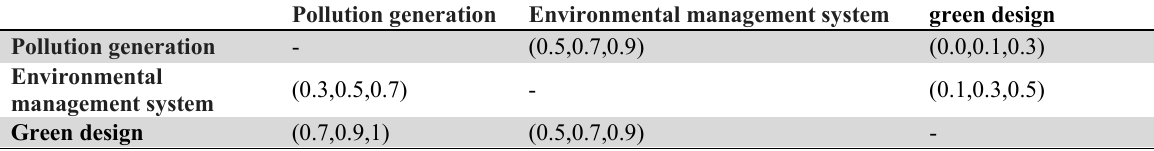
The relative importance of sub-criteria for the environmental benefits criterion when the sub-criteria of resource consumption is under control